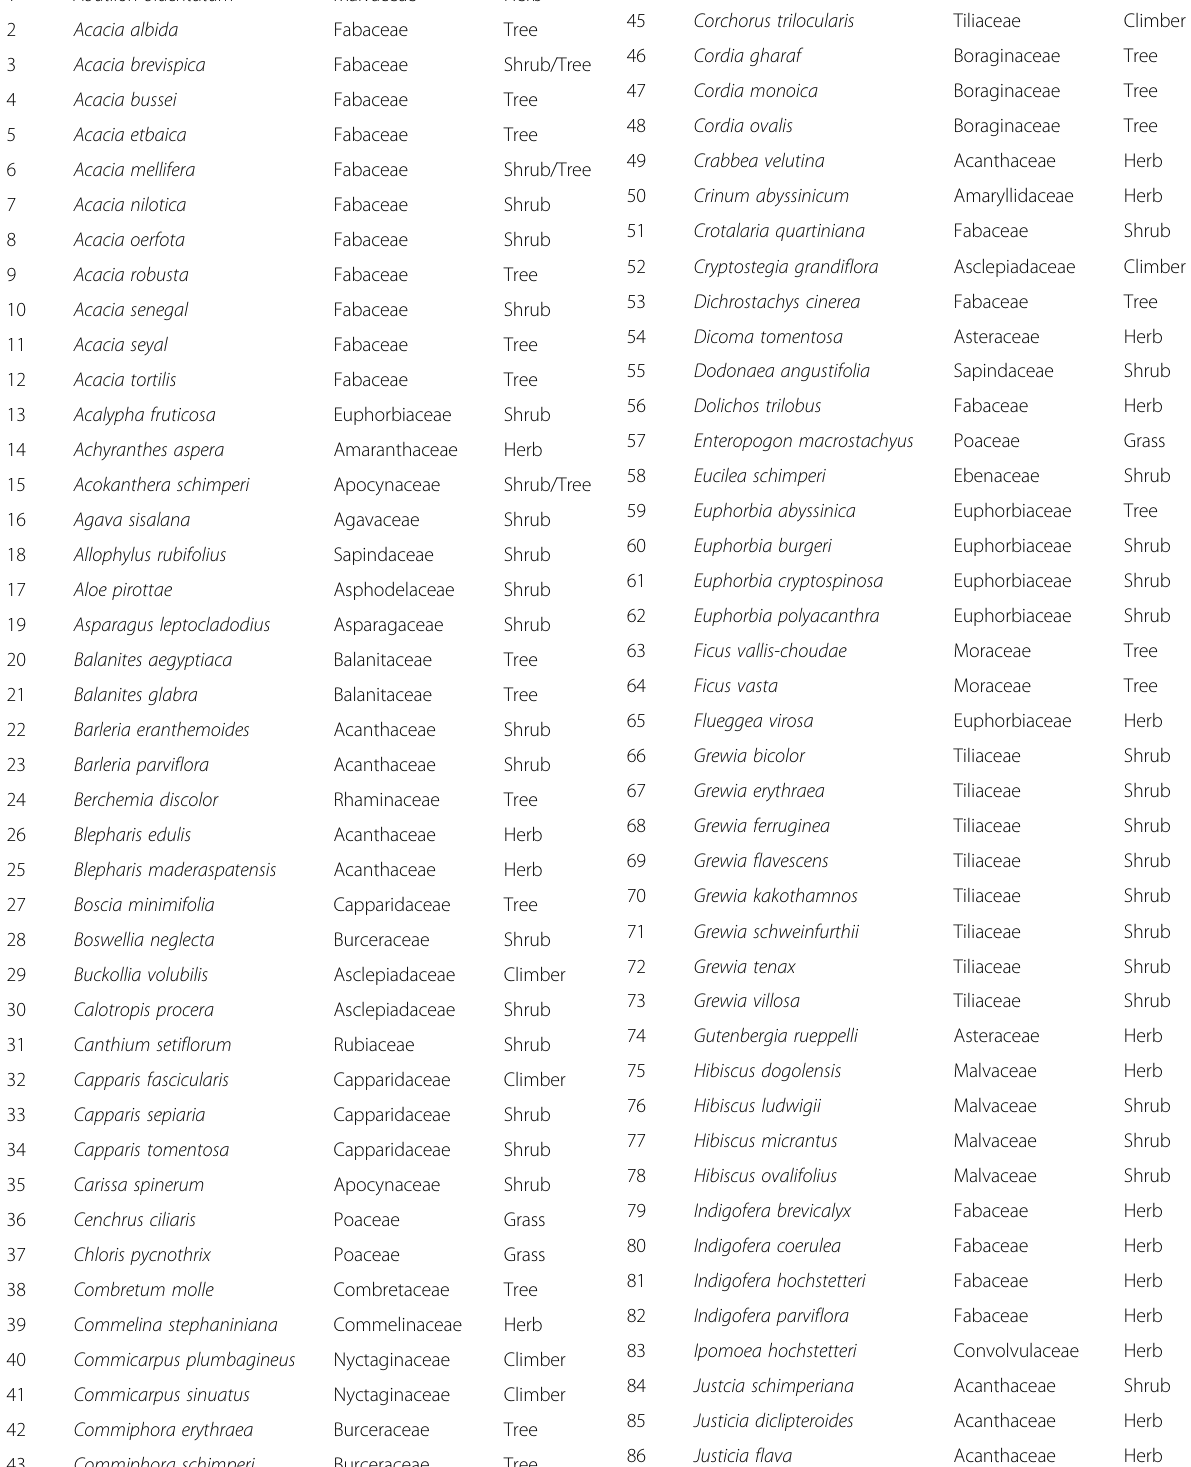
Table 5 List of plant species identified in the study